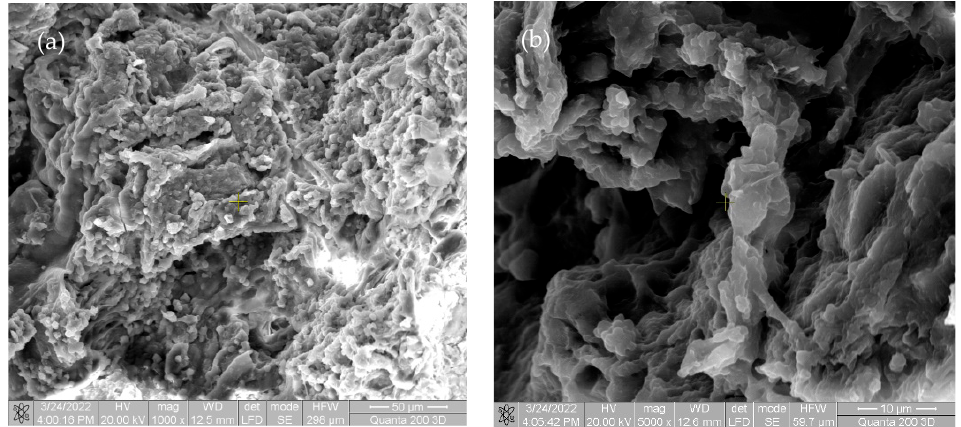
Figure 8. SEM images of rats after four weeks for Mg-0.5Ca-1.5Y ( a ) at magnification of 1000×; ( b ) at magnification of 5000×.